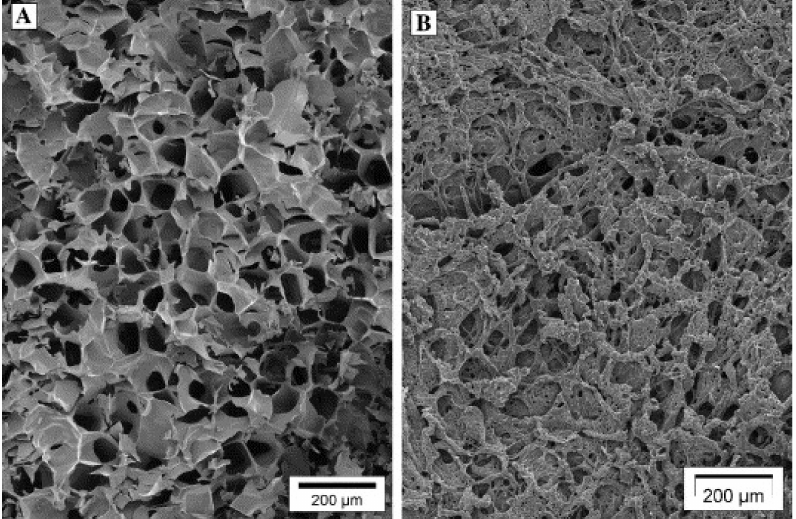
Figure 7. Scanning electron micrographs of freeze-dried ( A ) PVP and ( B ) sucrose. Note the partial collapse of sucrose and the apparition of holes in the structure whereas the plates of PVP are intact. Scale bar: 200 µ m. Adapted with permission from ref. [39]. 2021, Taylor & Francis.